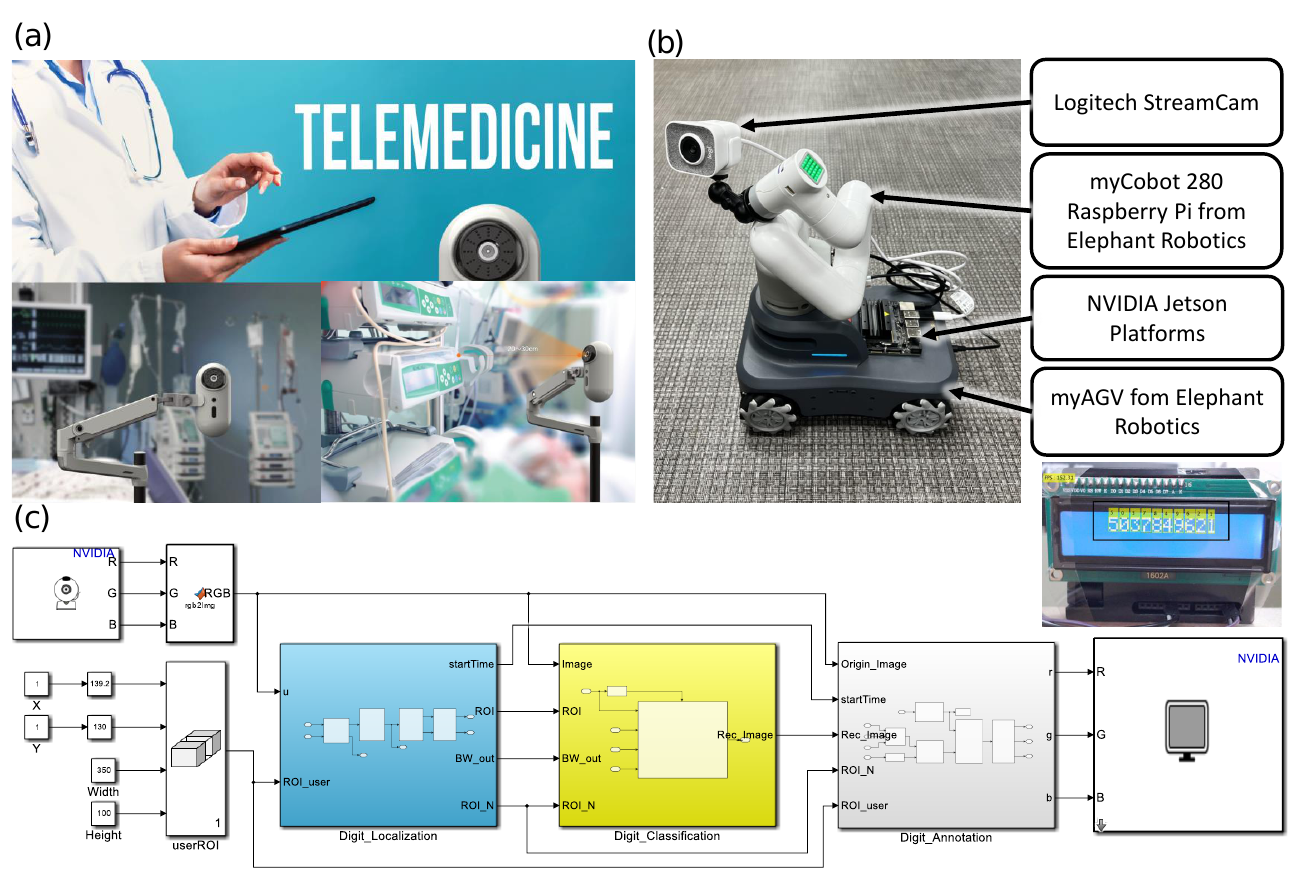
Figure 1. A real-time optical digit recognition embedded system for monitoring patients in ICUs. ( a ) A concept of ROMI for monitoring patients in ICUs. ( b ) Hardware prototype of ROMI. ( c ) System configuration of ROMI in Matlab